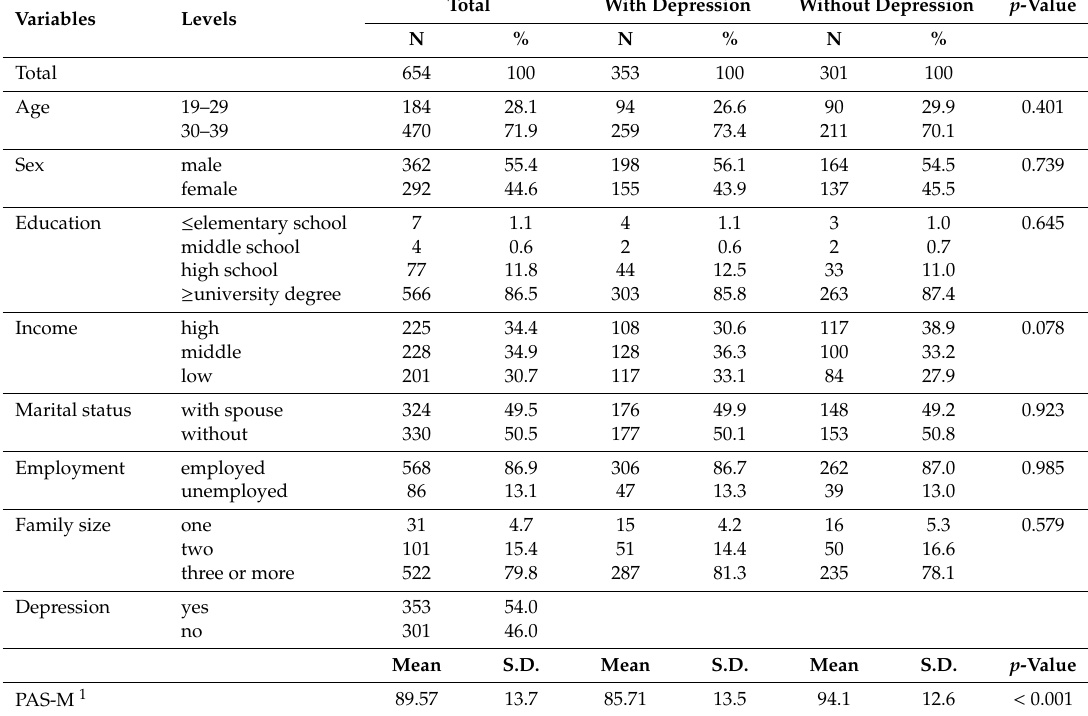
Table 3. General characteristics of the study